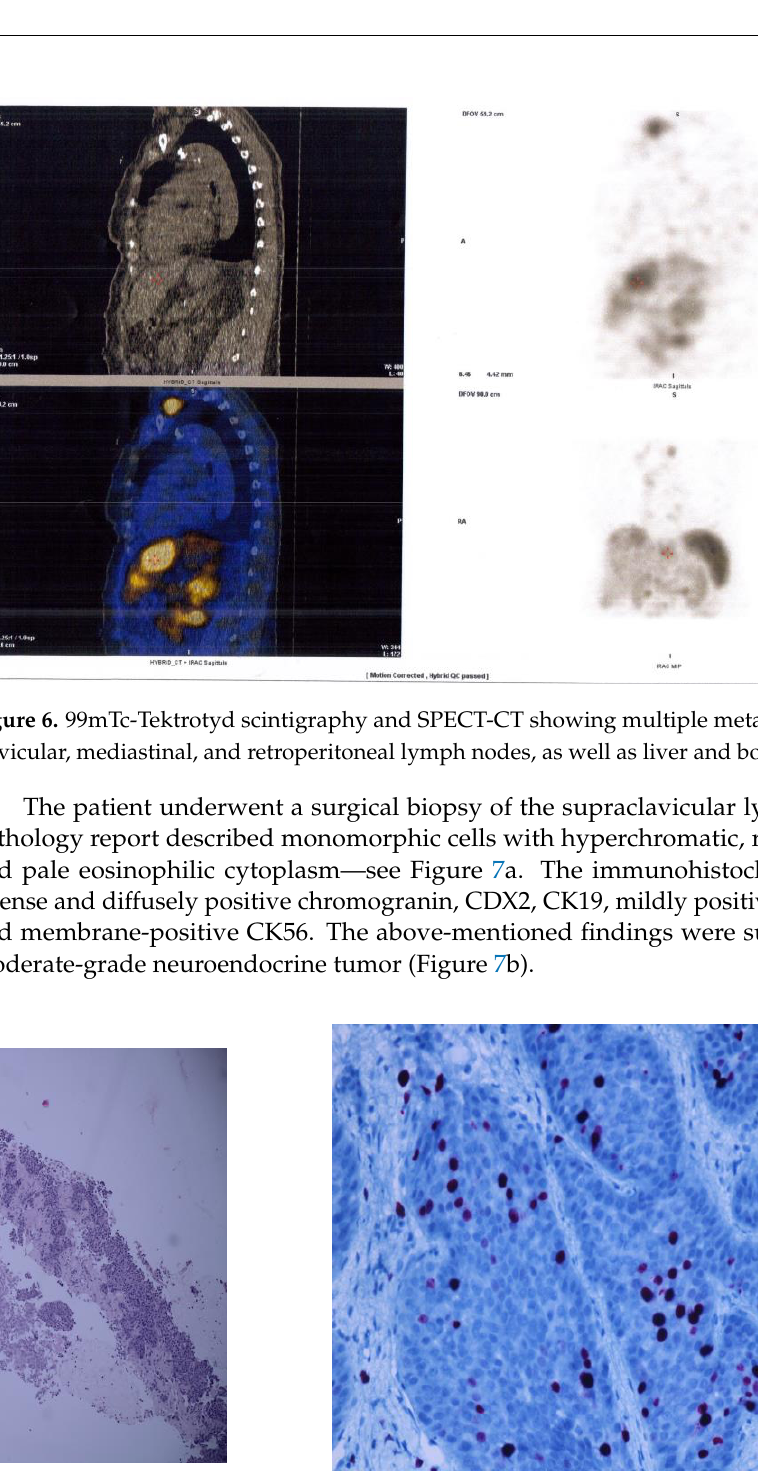
5 of 8 Figure 5. Cardiac MRI — severe tricuspid regurgitation.